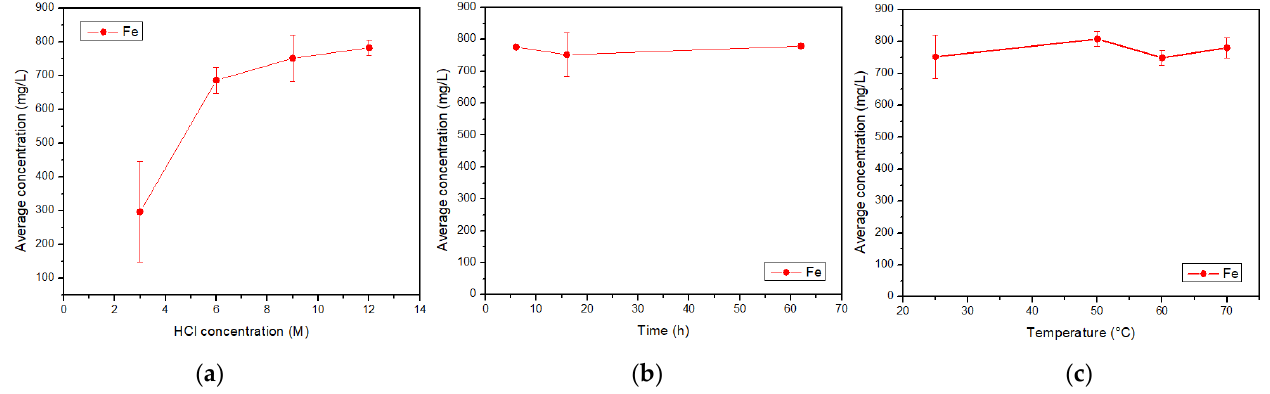
Figure 8. Average concentration of Fe as a function of ( a ) HCl concentration, ( b ) time and ( c ) temperature.